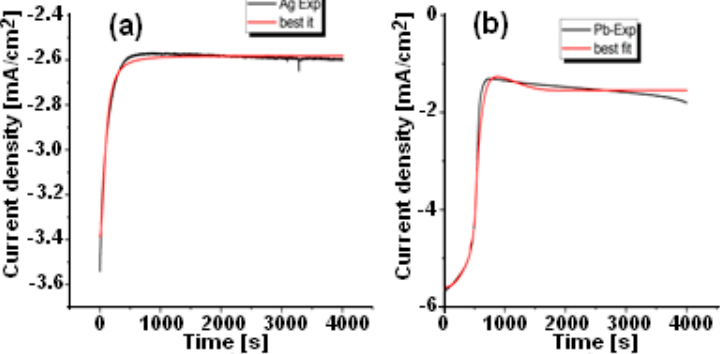
Figure 3. ( a ) Ag and ( b ) Pb electrodeposition current density versus time and their best fit according to Equation (2).